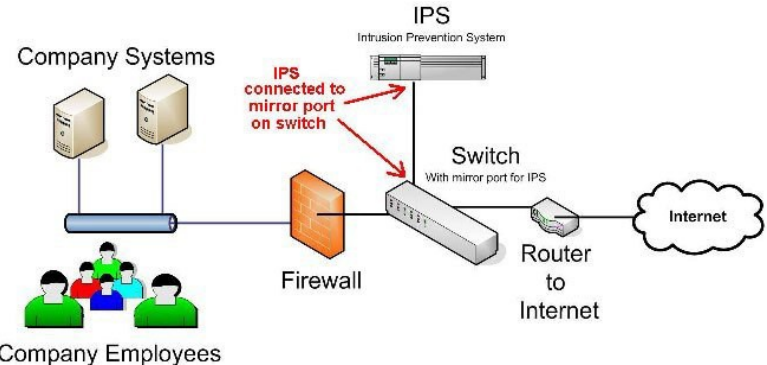
Figure 5. IPS architecture: IPS can be considered as an extension of IDS; it not only detects suspicious activity, but also takes protective measures.